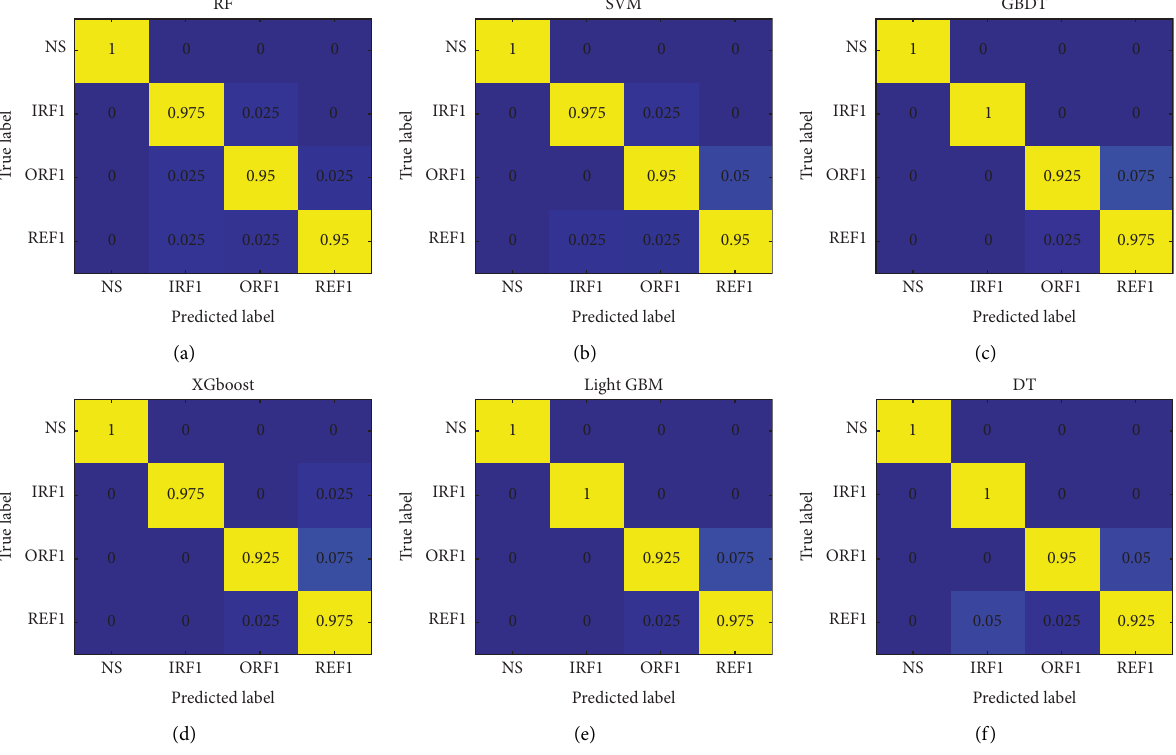
Figure 14: Fault diagnosis result under diferent number of training sample. Table 4: Diagnosis accuracy of diferent diagnosis model.